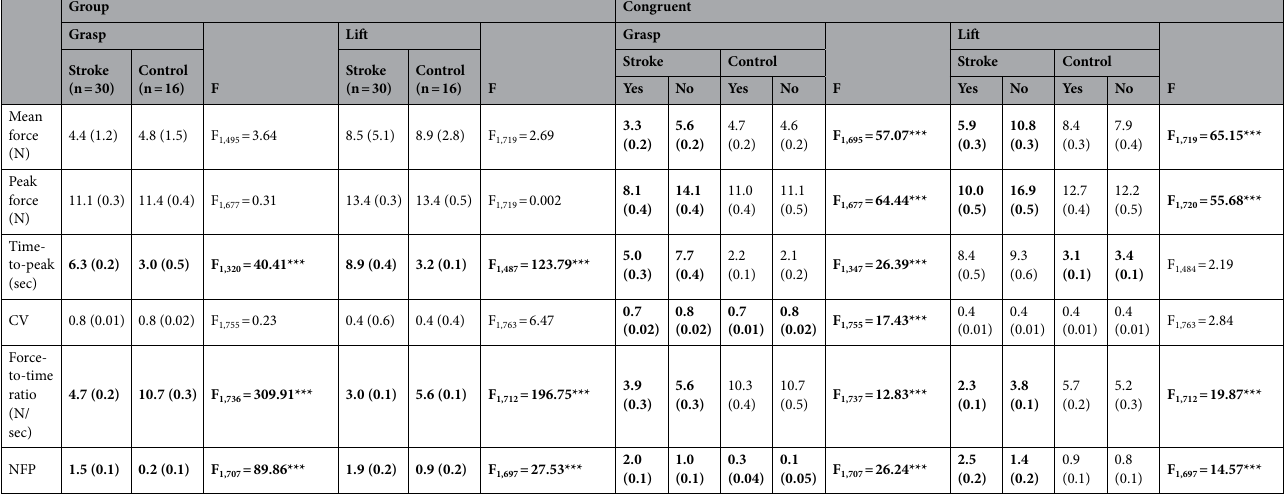
Group effect: There was no difference in the peak forces between the groups ( Grasp : F 1,718 = 0.15, p = 0.695 Lift : F 1,758 = 0.002, p = 0.966). In the stroke group, the peak forces were higher when the tested (affected) hand was the non-dominant one ( Grasp : F 1,431 = 87.2, p < 0.001; Lift : F 1,459 = 80.94, p < 0.001). This difference was not